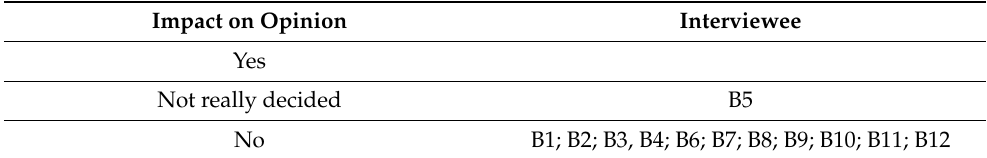
Table 4. Impact of tourism reduction on residents’